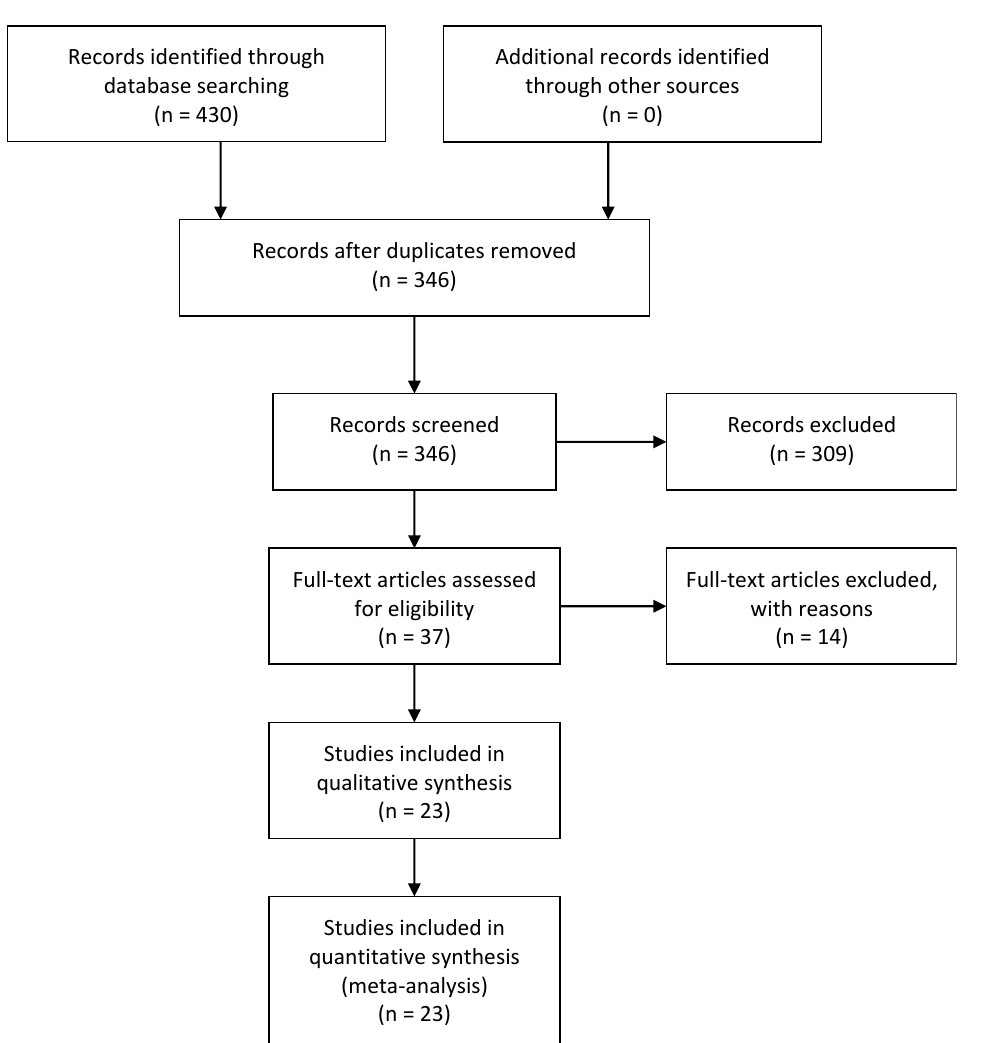
Figure 1. PRISMA Diagram Detailing the Study Selection Process.